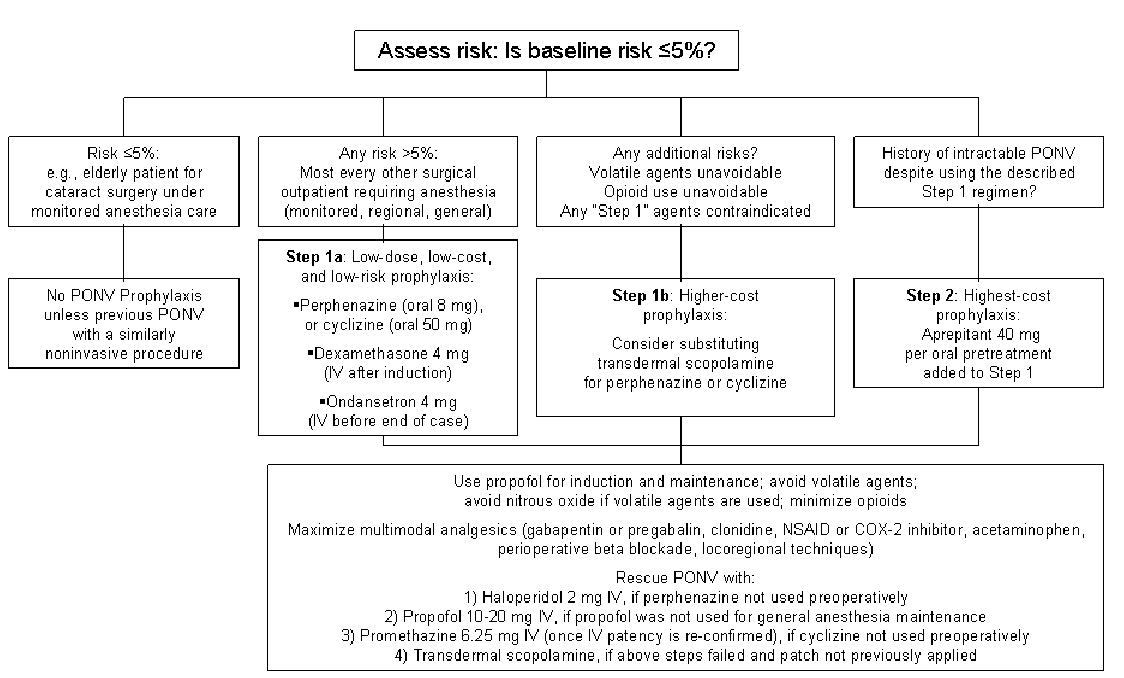
FIGURE 2. PONV in outpatients (prophylaxis and treatment): a “zero-tolerance” strategy